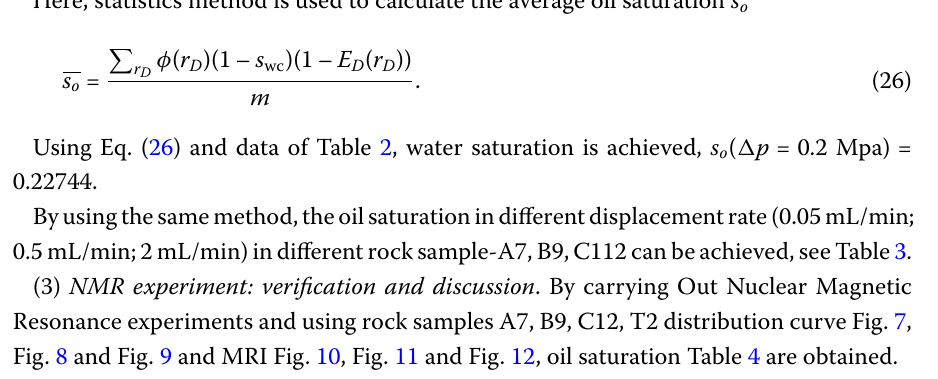
Figure 6 Oil displacement efficiency changed by the occurrence radius in GD7-42-J195TG block